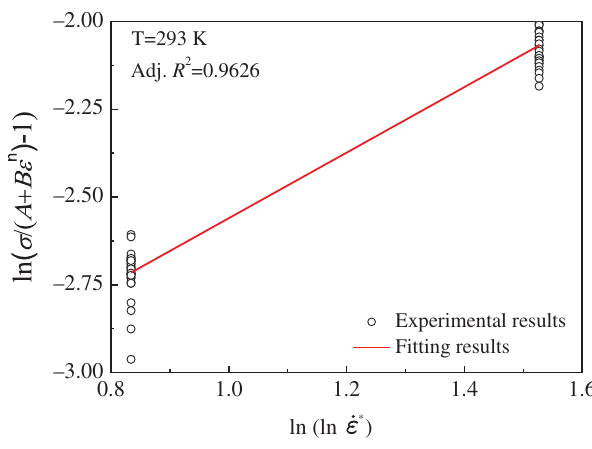
Figure 7: The relationship between ln ð σ = ð A + B ε n Þ − 1 Þ and ln ð ln _ ε * Þ .